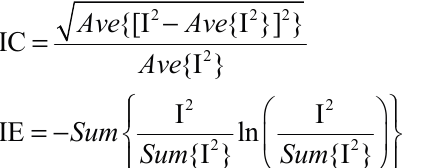
Figure 5b is obtained via the existing sparsity-driven IFFT-SR method, where range compression